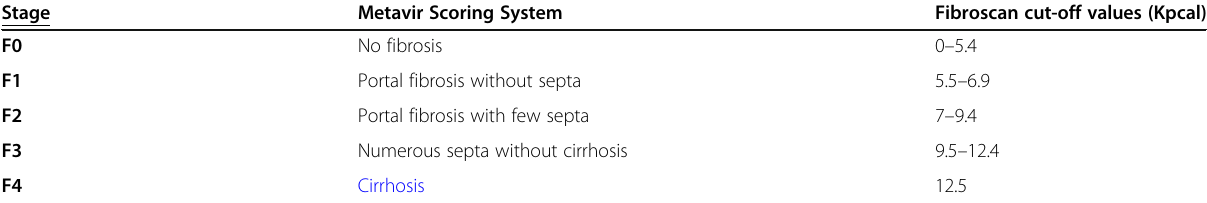
Table 1 Histological staging system of METAVIR